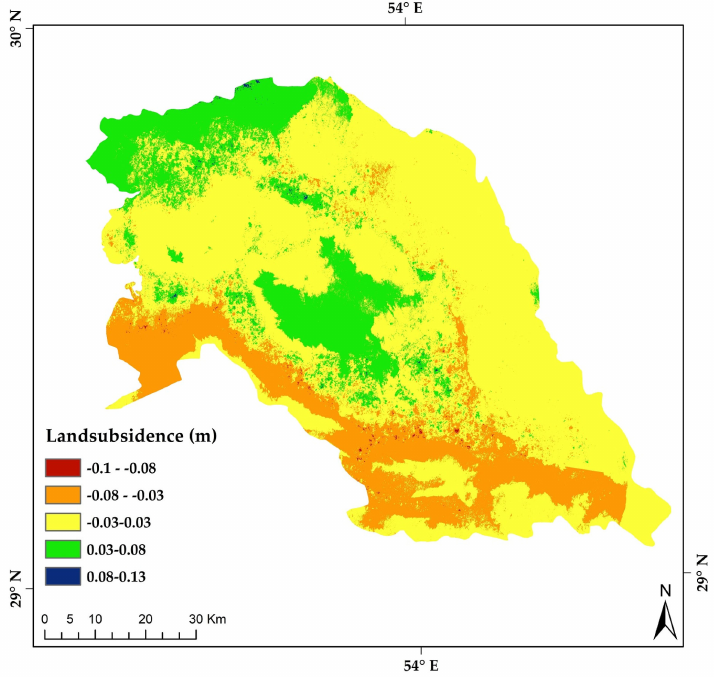
Figure 5. The study region’s land subsidence (LS) map (January to December